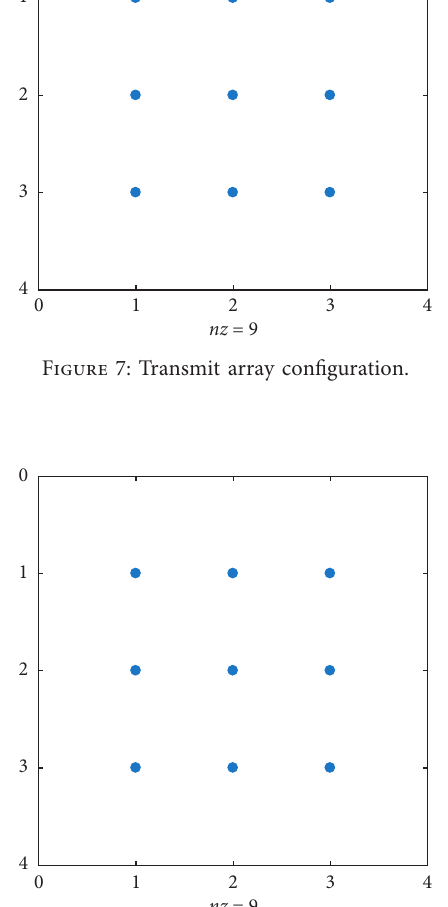
Figure 11: Type 4 thinned virtual array configuration.